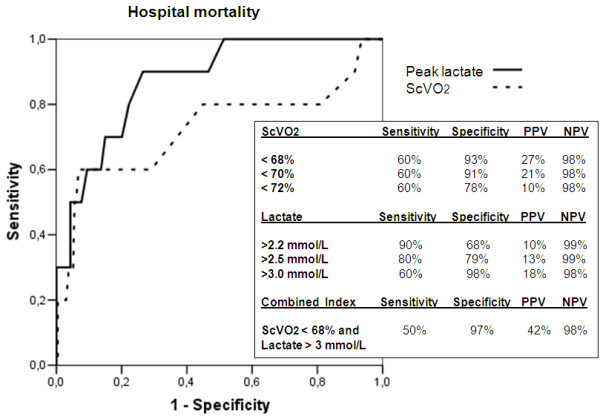
Receiver operating characteristic curve for mortality. Different cut-off values for nadir ScVO2, peak lactate, and a combined index are explored. PPV, positive predictive value; NPV, negative predictive value.